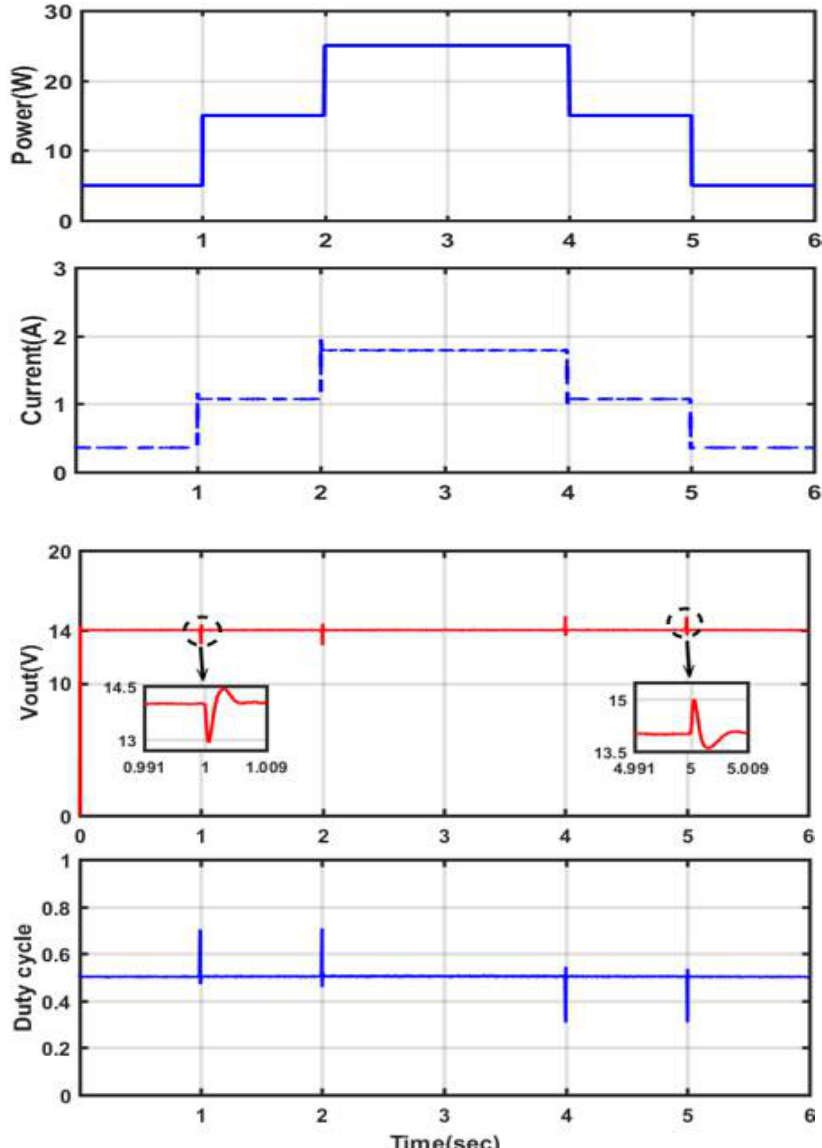
Figure 10. Changes in output voltage and duty cycle with an RST controller in response to CPL variation.